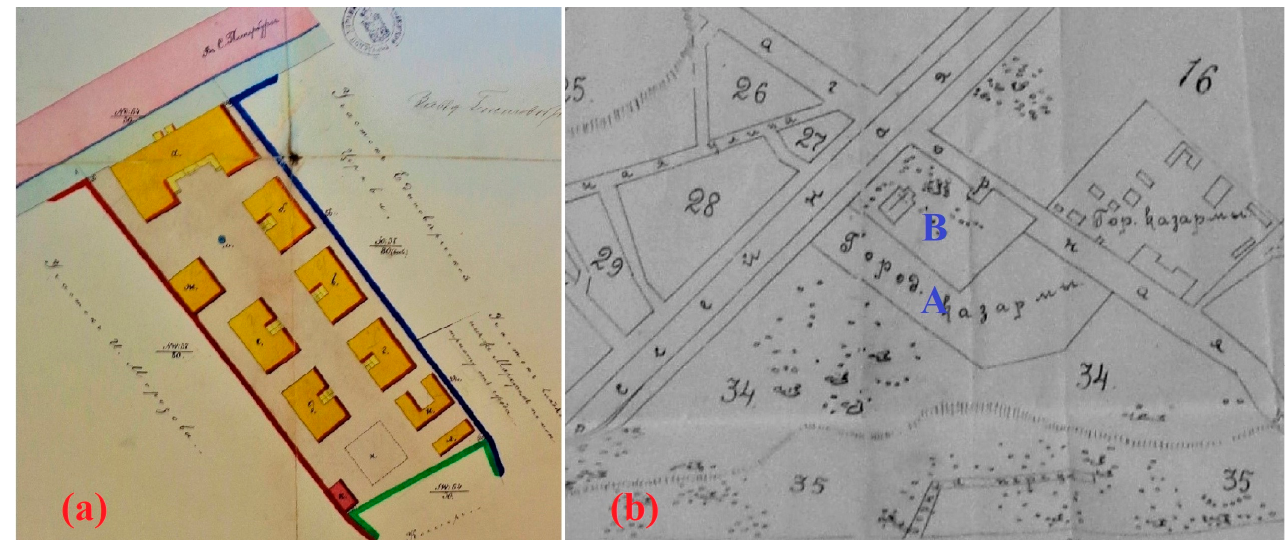
Figure 3. ( a ) The plan of the plot where Leiba Markus built wooden barracks. (source: Lithuanian State Historical Archives). ( b ) Plan of the block in 1913. The location of the wooden barracks is marked with the letter A and the location of Edinoverie Church with the letter B (source: Lithuanian Central State Archives).